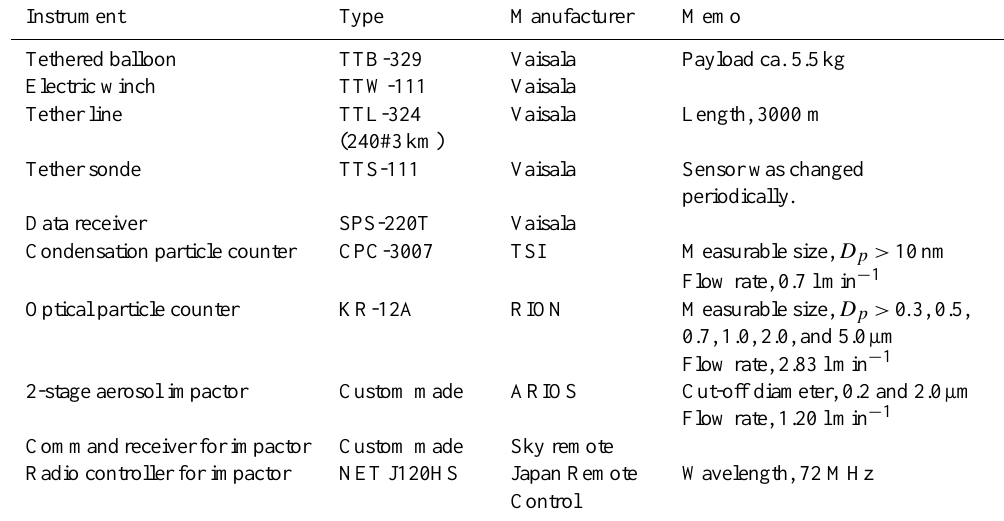
Wavelength, 72 Control